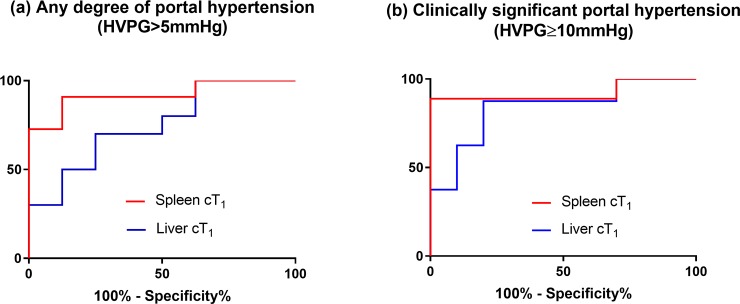
Diagnostic accuracy of spleen and liver iron corrected T1 (cT1) for portal hypertension severity assessment.(A) Receiver operating curves (ROC) of spleen and liver cT1 for the diagnosis of any degree of portal hypertension. There was a significant diagnostic accuracy for spleen cT1 with an area under the ROC (AUROC) of 0.92 (p = 0.002). Liver cT1 had an AUROC of 0.73 with a trend towards significance (p = 0.110).(B) ROC curves of spleen and liver cT1 for the diagnosis of clinically significant portal hypertension. Both variables had significant diagnostic accuracy with AUROC of 0.92 (p = 0.002) for spleen cT1 and 0.81 (p = 0.026) for liver cT1.